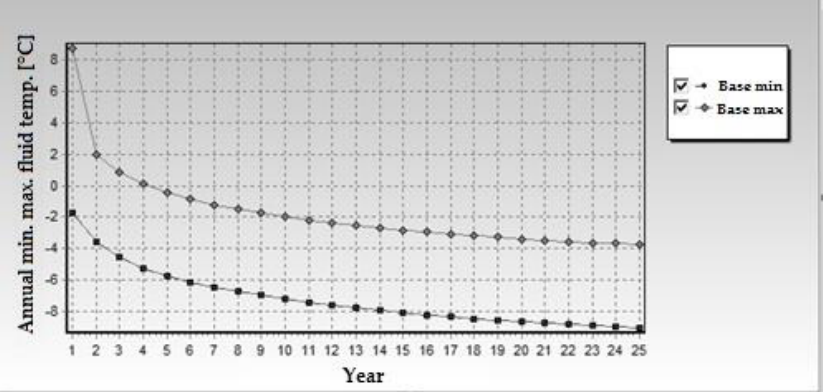
Figure 9. Temperature progression over 25 years under Scenario 2 (calculated by [16]).